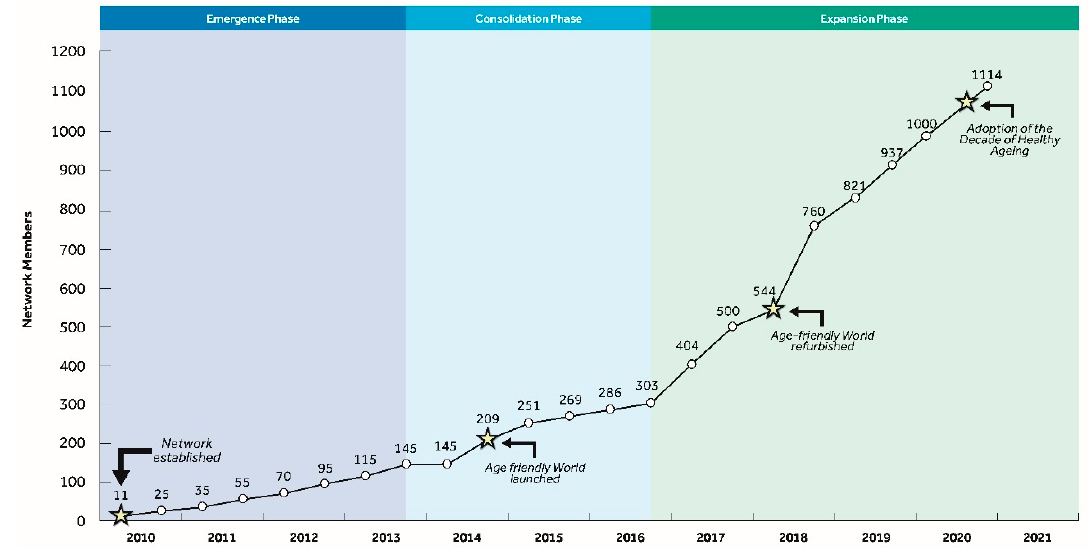
Figure 1. Growth of the Global Network of Age-Friendly Cities and Communities (GNAFCC) (adapted from [7]) .